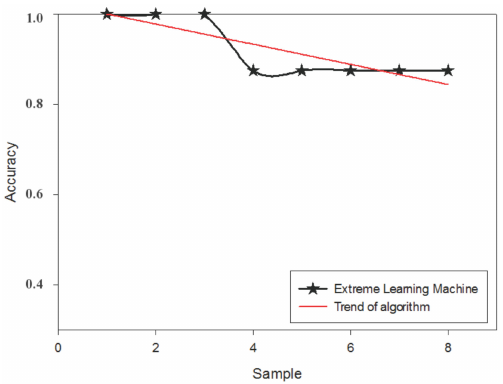
Figure 13. Extreme learning machine algorithm for marine fuel system fault